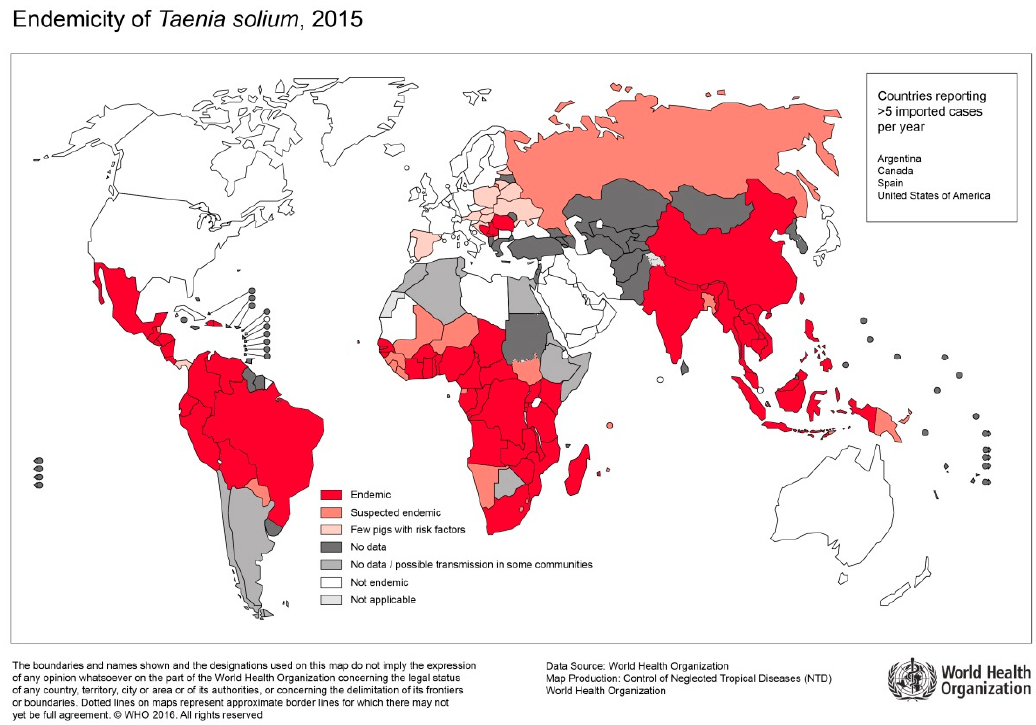
Figure 5. Endemicity of T.solium, 2015 (Sorce: WHO, website: https: // www.who.int / taeniasis / Endemicity_Taenia_Solium_2015.jpg?ua =